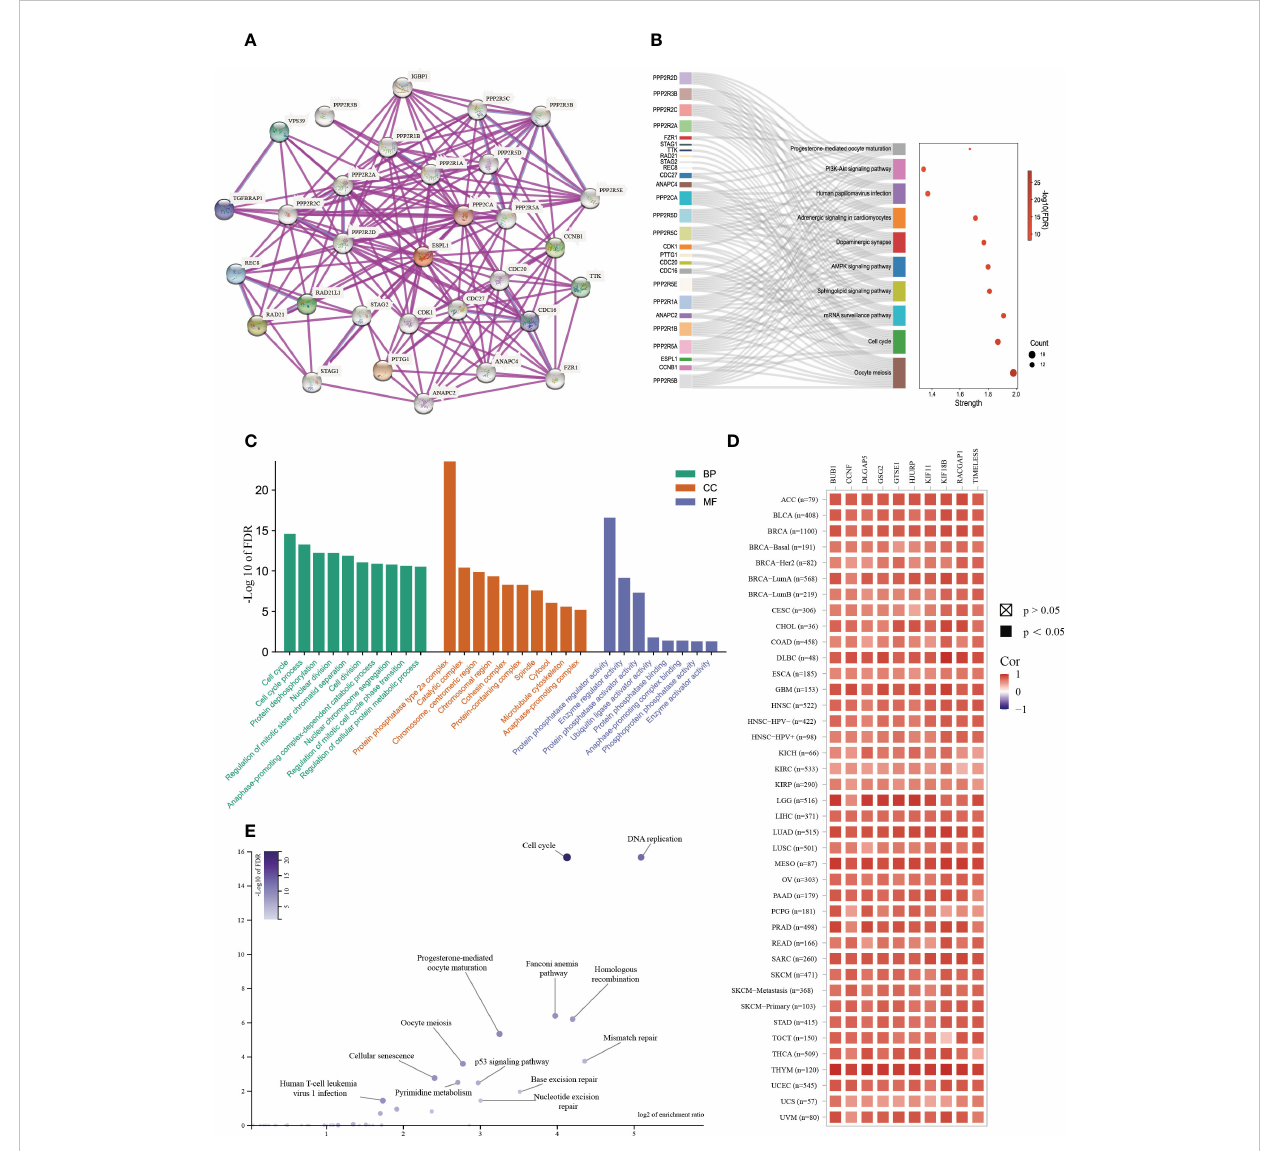
FIGURE 7 Enrichment analysis of ESPL1-related partners. (A) PPI analysis of ESPL1. (B) Sankey diagram of KEGG pathway analysis results. (C) GO functional classi fi cation. (D) Heat map of ESPL1 correlations with the top 10 similar genes in different cancer types. (E) Volcano plot of KEGG results for 200 similar genes. PPI, protein-protein interaction; KEGG, Kyoto Encyclopedia of Genes and Genomes. BP, biological process. CC, cellular component. MF, molecular function. FDR, false discovery